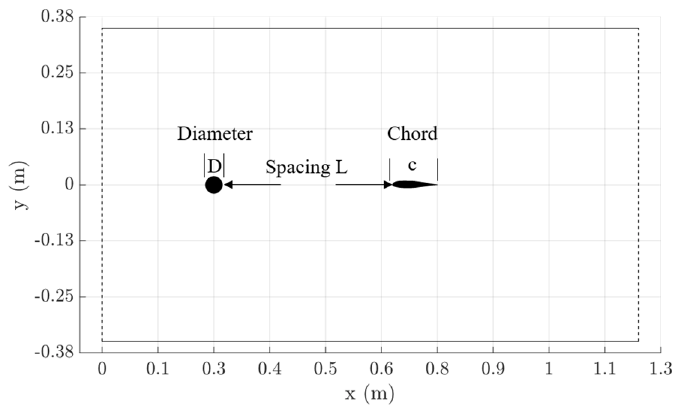
Figure 3. Diagram of a 71 cm test section and experimental setup.